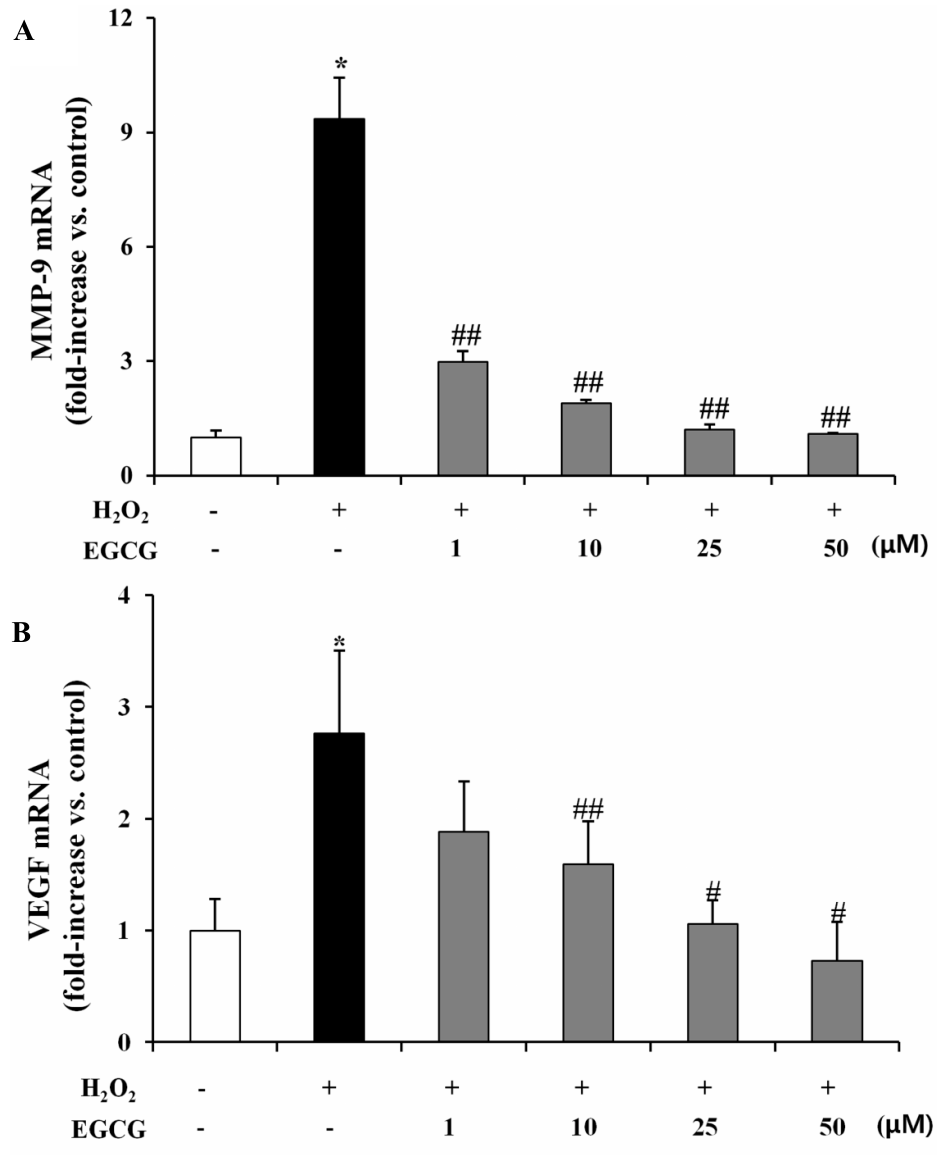
O (3 00 μ M) or EGCG (1–50 μ M) treatment was 2 2 O and EGCG 2 2